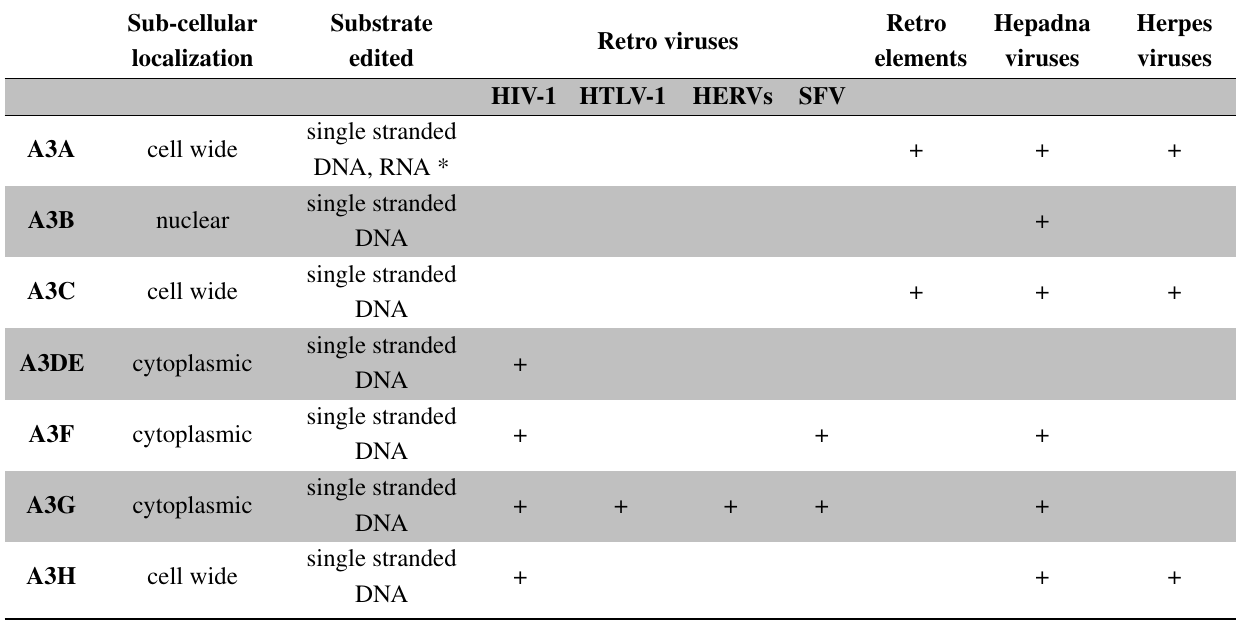
Table 1. Summary of the anti-viral activity of the different APOBEC3 isoforms. * It has been recently shown that A3A can also edit RNA transcripts